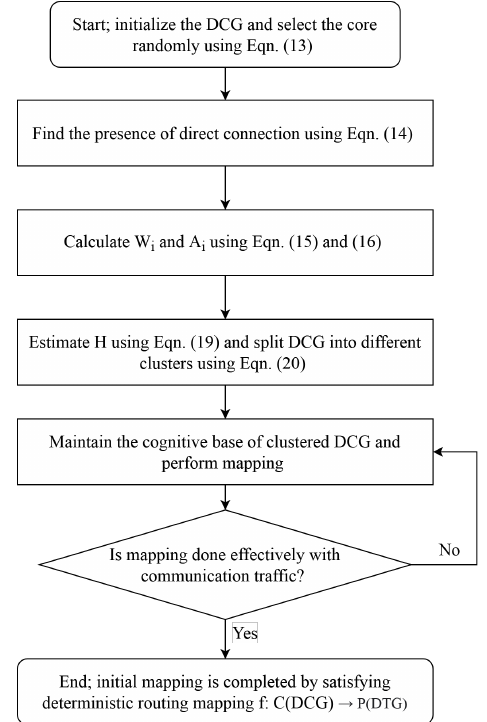
Figure 1. Flowchart for initial